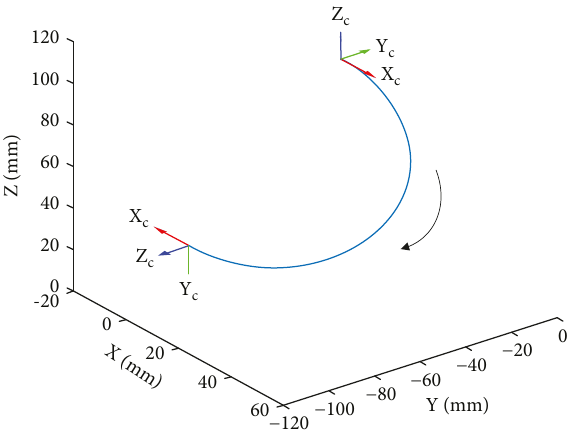
Figure 8: Position and attitude in the aerial and terrestrial mode of the wheel.